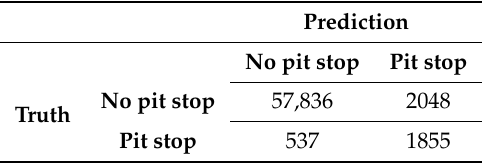
Table 12. Confusion matrix of the predictions of the final trained pit stop decision NN on the entire database (filtered according to Section 3.2.2).